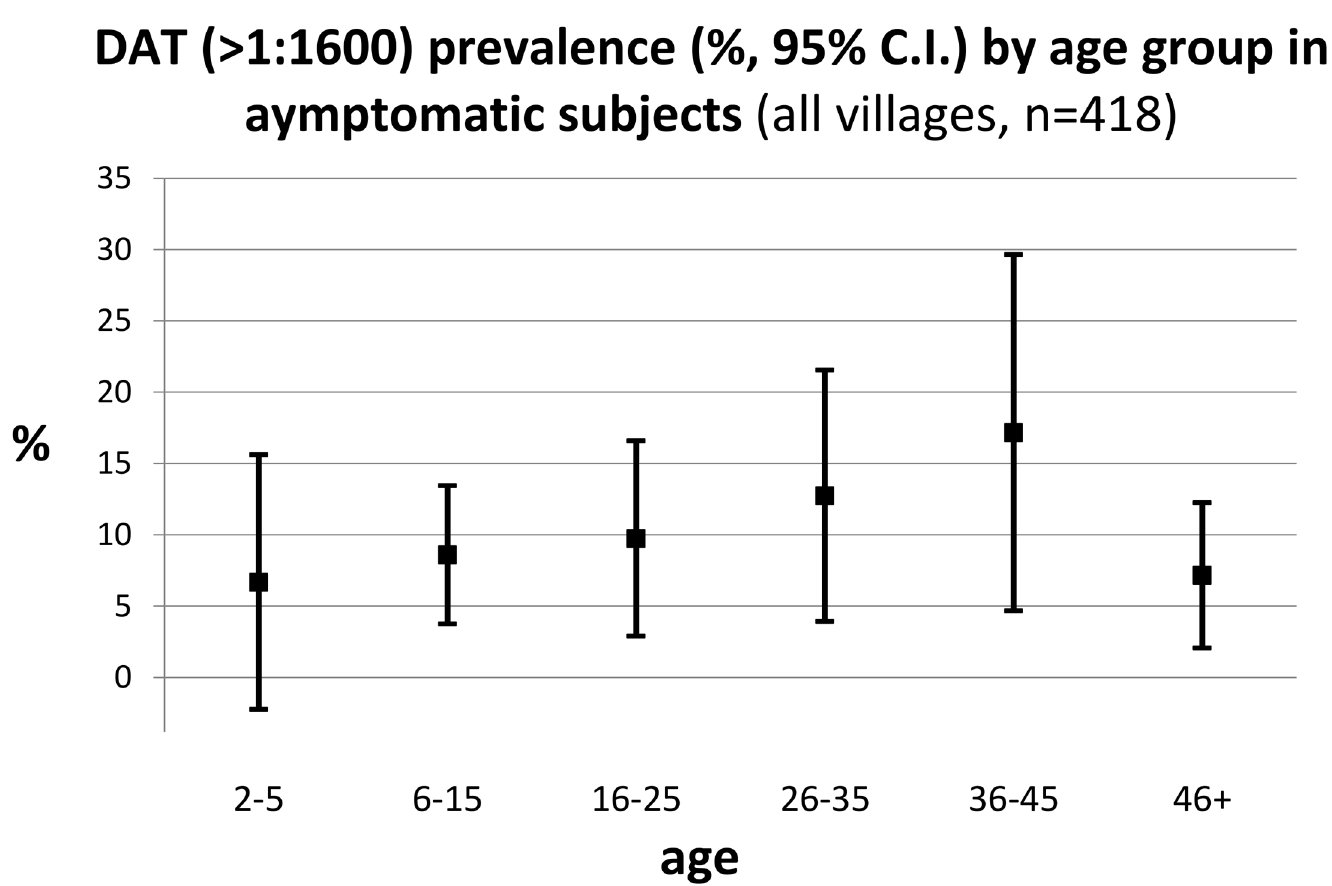
Fig 2. Seroprevalence by age